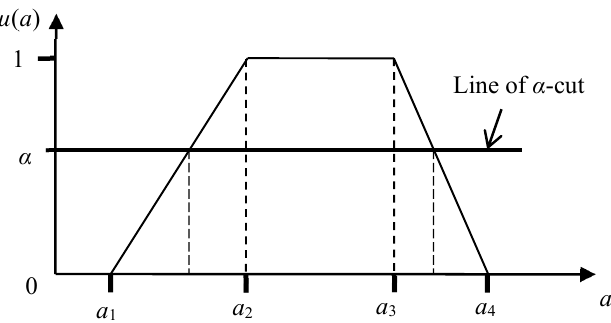
Figure 1. Illustration of a trapezoidal fuzzy number and α -cut interval (where µ ( a ) is the membership function, and α is the minimum membership value that defines the upper and lower bounds of the interval).